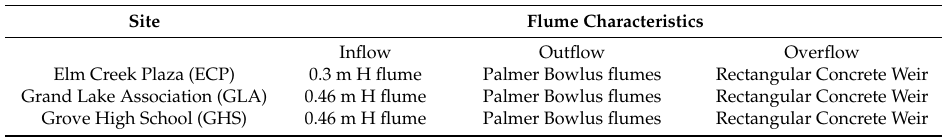
Table 3. Inflow, outflow, and overflow flume characteristics for three bioretention cells in Grove, OK,